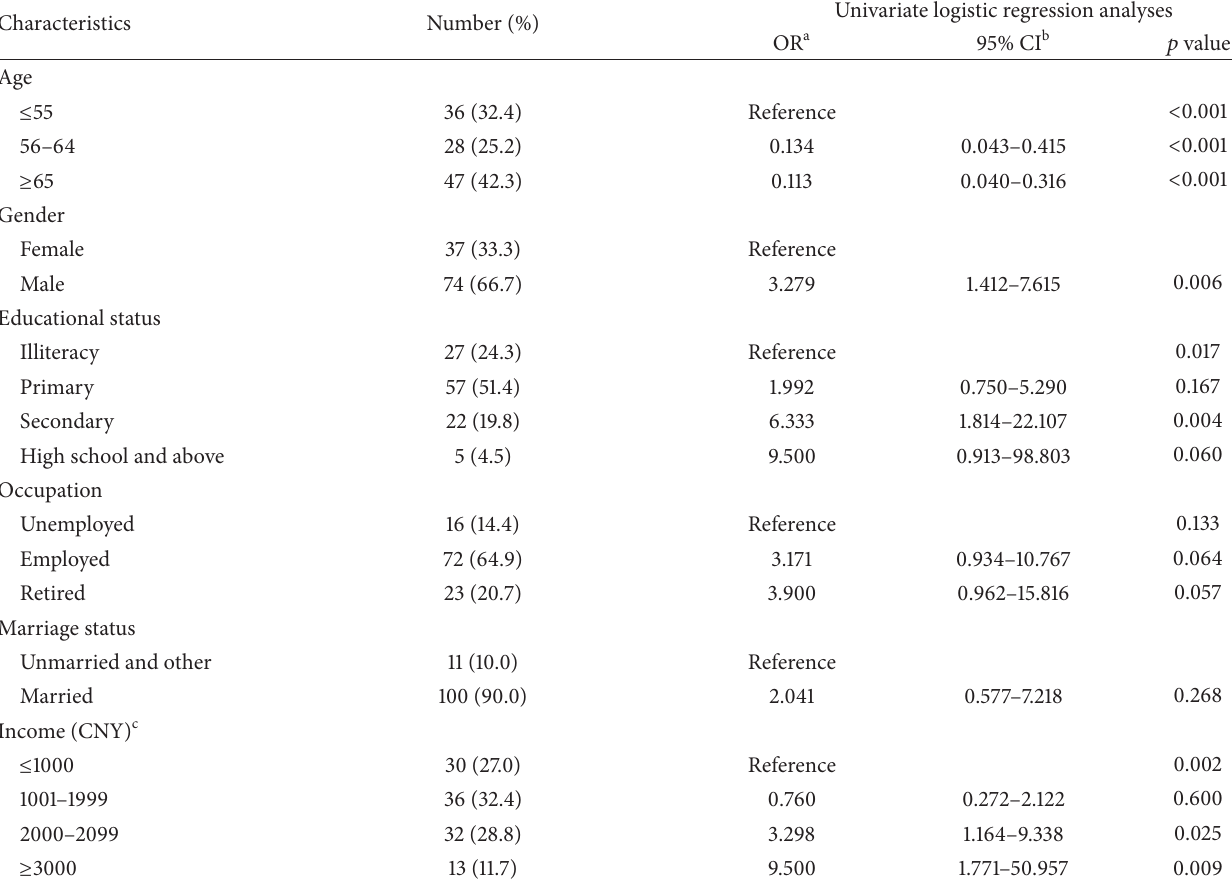
Table 1: Sociodemographic profile of participants and the association with practices ( 𝑛 = 111 ).